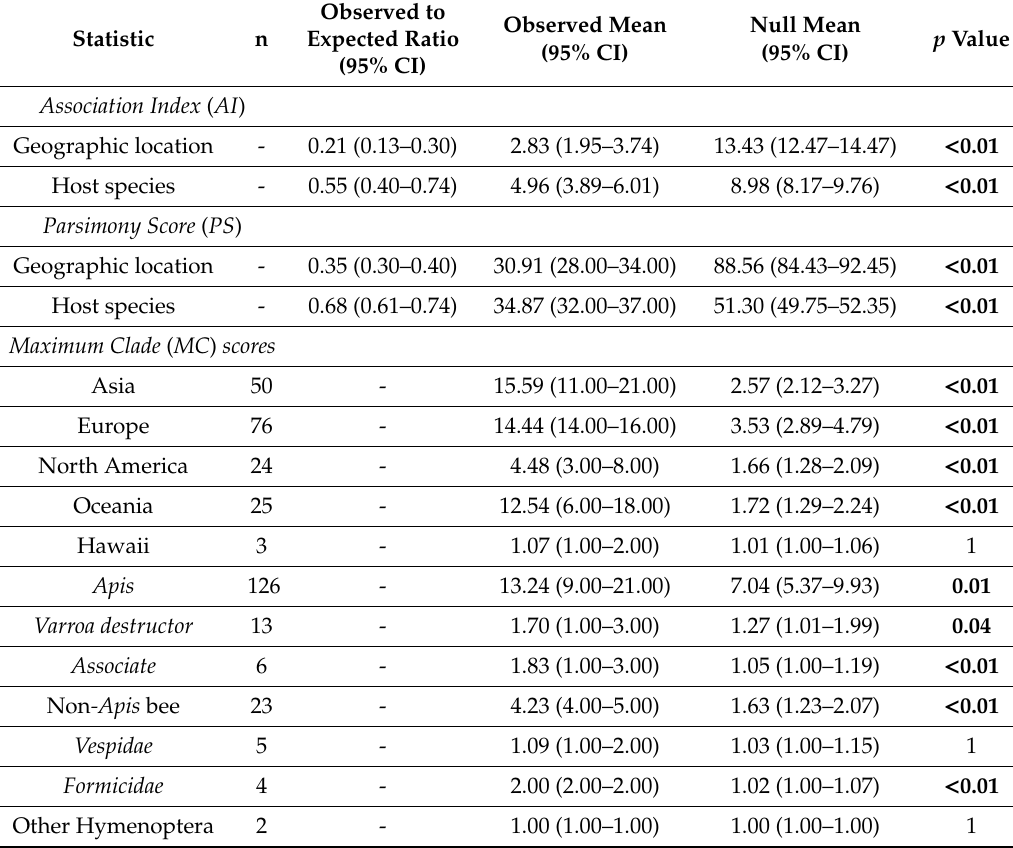
Table 3. Trait–tip association in deformed wing virus (DWV), as calculated with 500 random trees (replicates) in BaTS (Bayesian tip-association significance testing) [52]. Significant p values are in bold font. Low parsimony score (PS) represents fewer state changes on the tree and stronger trait–tip association. Maximum clade (MC) scores show the maximum size of a clade for a trait state; a high MC is positively correlated with trait–tip association. The geographic region of South America was only represented by one sample and is not shown.